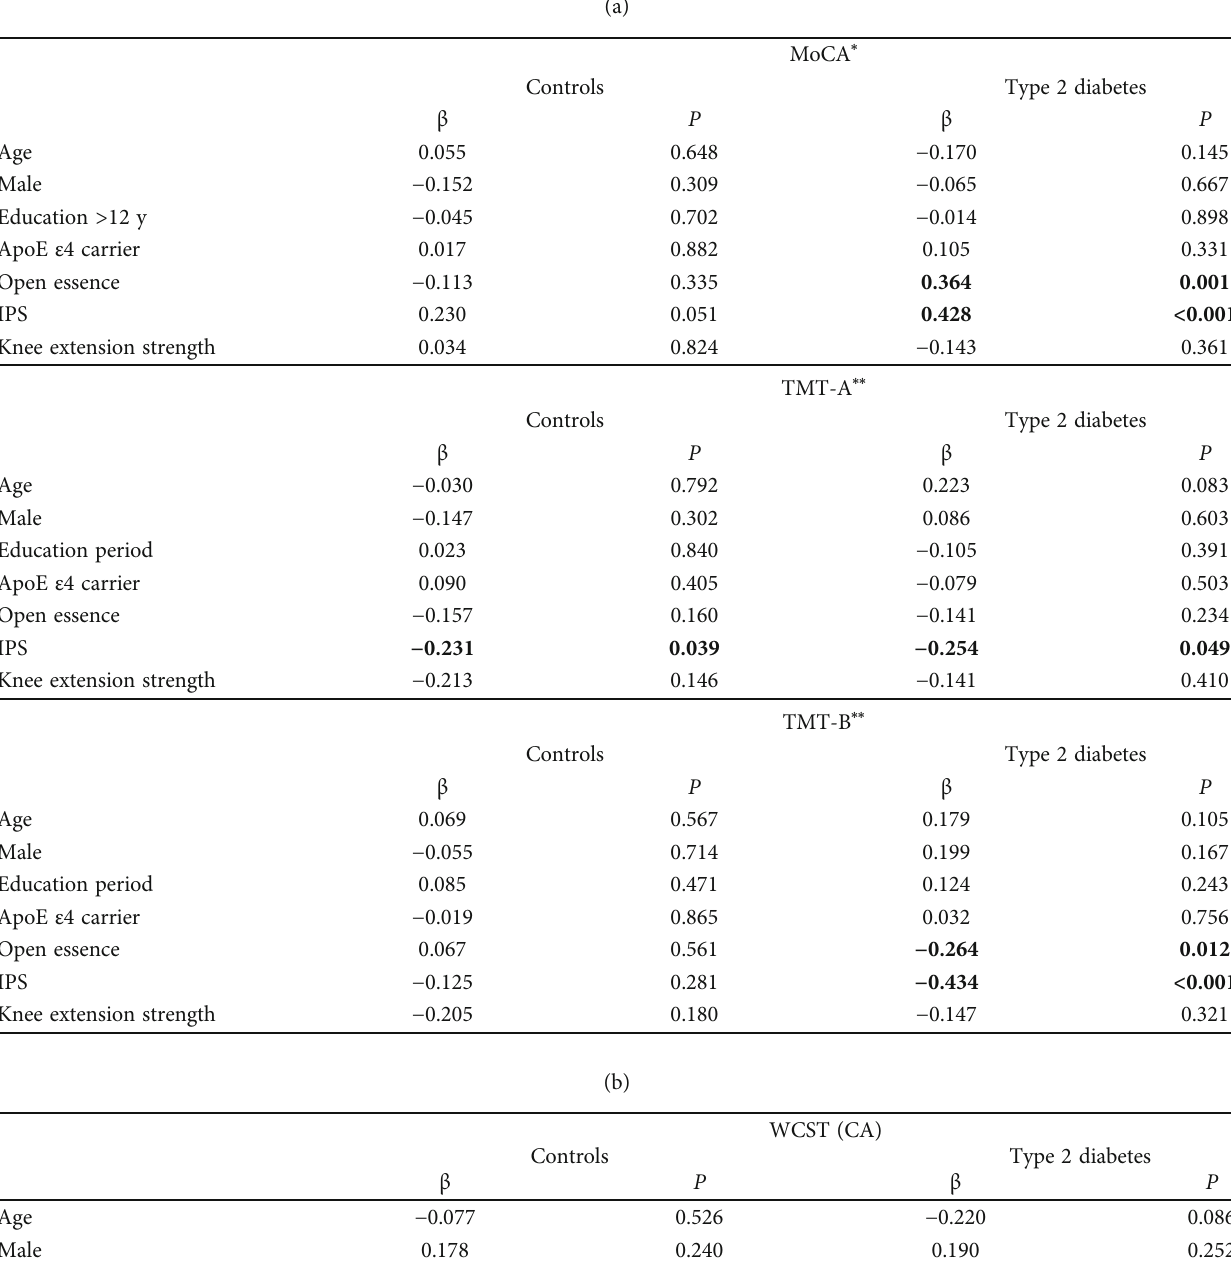
Table 7: Multiple linear regression analyses of the cognitive function strati fi ed according to the presence or absence of